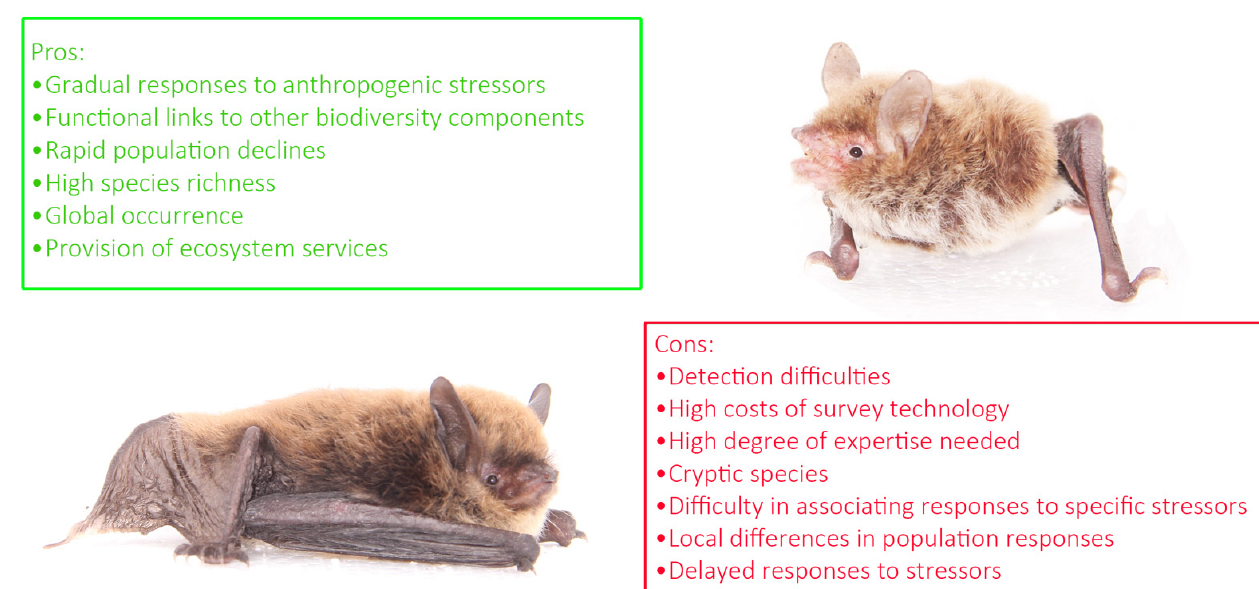
Figure 2. A schematic list of pros and cons of using bats as bioindicators.